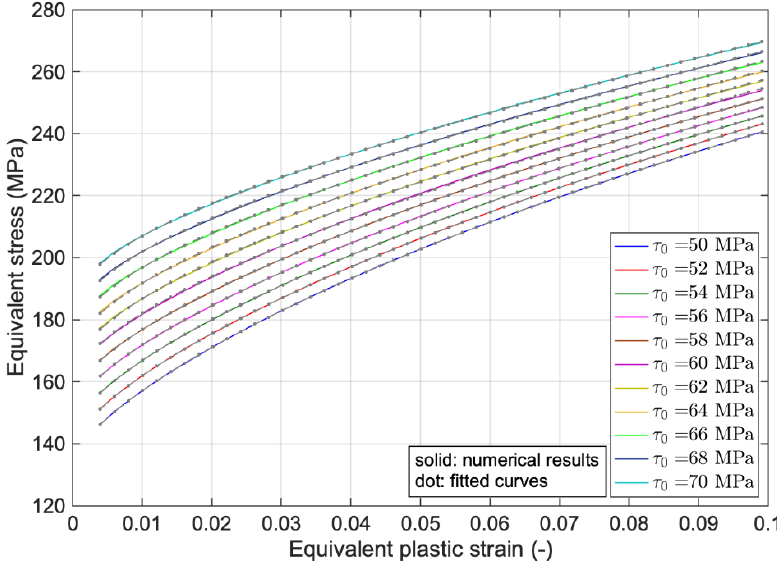
Figure 3. Comparison between numerical results and fitted curves with change in τ 0 .